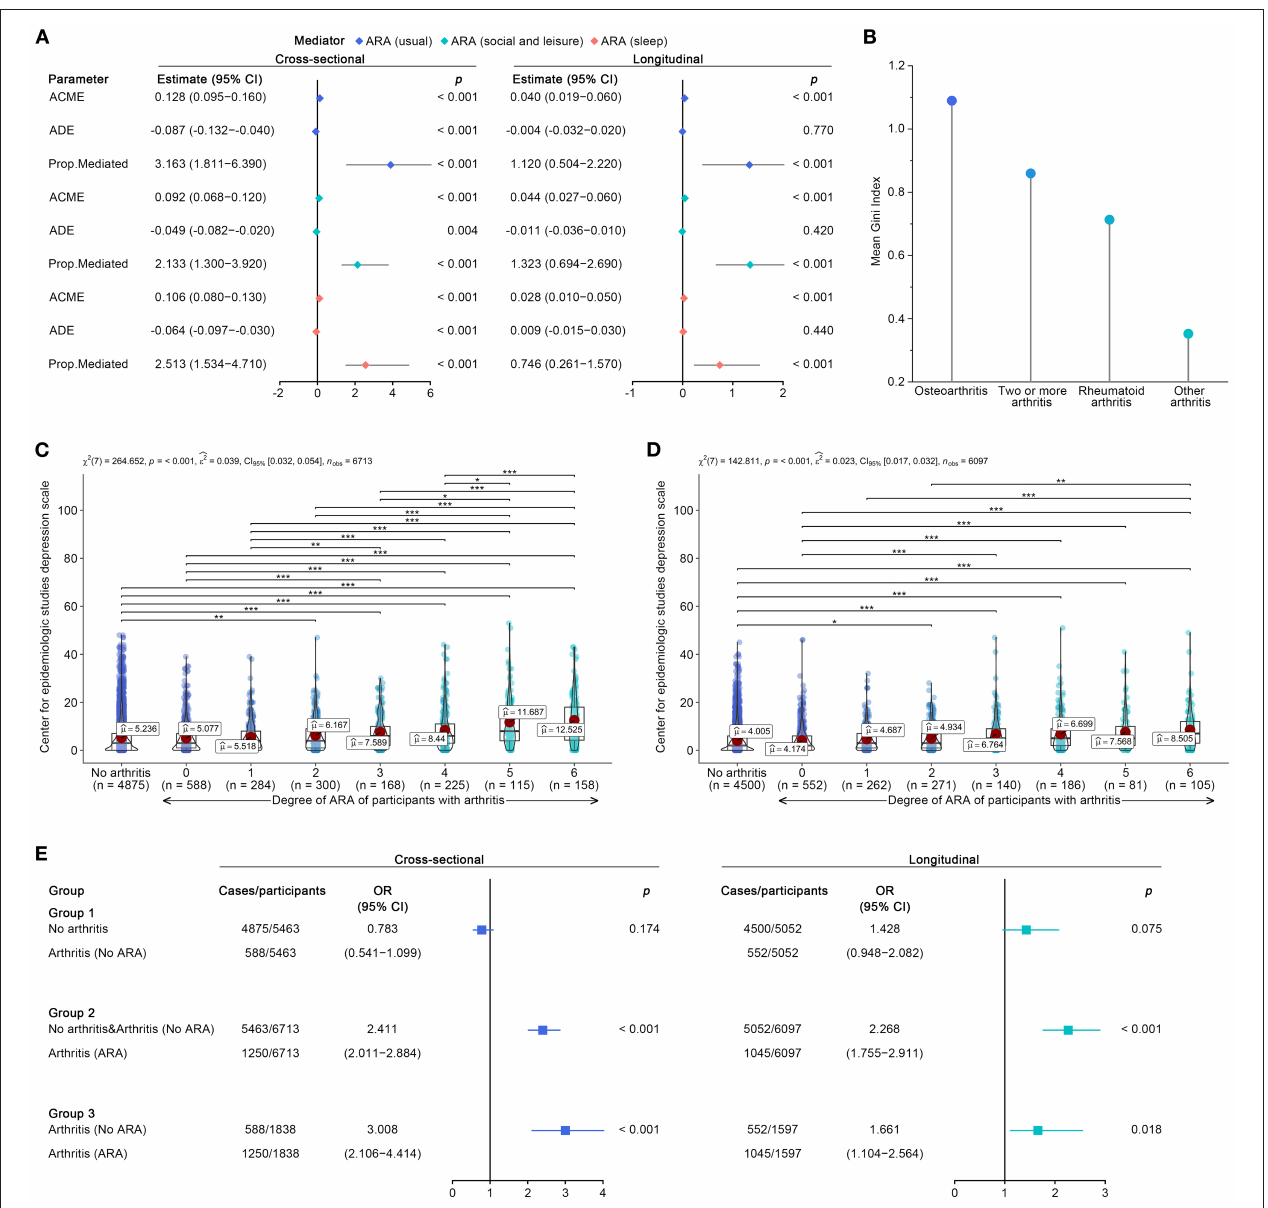
FIGURE 2 | Further analyses for restriction of activities, and subtypes in arthritis. (A) Results of cross-sectional and longitudinal mediation analysis for arthritis, in which ARA (usual), ARA (social and leisure), and ARA (sleep) were considered as potential mediators. (B) Random-Forest algorithm-derived Mean Gini Index weighed the contribution of arthritis subtypes to outcomes of depression. (C) Cross-sectional potential difference of depressive symptoms among participants with/without arthritis (stratified by degree of ARA). (D) Longitudinal potential difference of depressive symptoms among participants with/without arthritis (stratified by degree of ARA). (E) Stratified analyses using binomial logistic regression quantified associations between arthritis (No ARA), arthritis (ARA), and depression at baseline and Wave 2. ARA, Restriction of activities caused by arthritis; ACME, average causal mediation effects; ADE, average direct effects; Prop. mediated, proportion mediated; χ 2 , chi-square; n obs , number of observation; ˆ u , group mean; ˆ ε 2 , effect size of ε 2 ; p , p -value. p -value adjusted < 0.05 was represented by “*,” p -value adjusted < 0.01 was represented by “**,” p -value adjusted < 0.001 was represented by “***”.